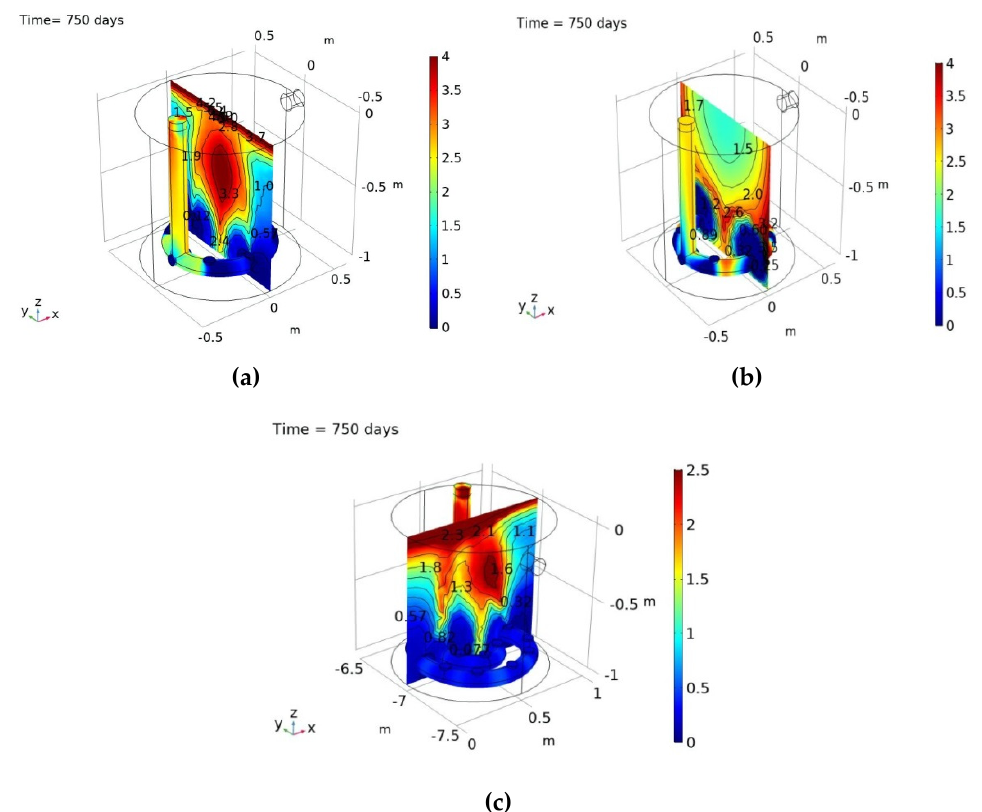
Figure 4. Distribution pattern in filter bags filled with ( a ) Polonite, ( b ) Top16 and ( c ) Filtralite P and fitted with a circular slotted distribution pipe. Color indicates the P concentration (mg L − 1 ) in the material after filtration of wastewater containing 12 mg P L − 1 over 7 months.